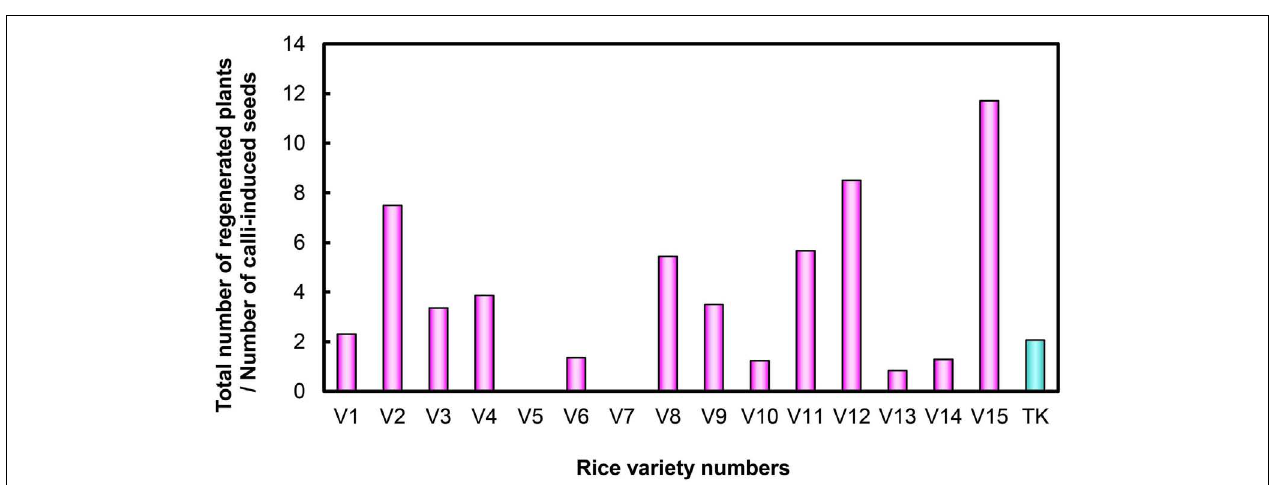
FIGURE 3 | Regeneration efficiency of Myanmar rice varieties and theTsukinohikari variety .V1–V15 under horizontal bar represent the rice variety numbers described in Table 1 andTK meansTsukinohikari. Numbers on vertical bars are quotients of total numbers of regenerated plants divided by numbers of callus-induced seeds, which represent regeneration efficiency.